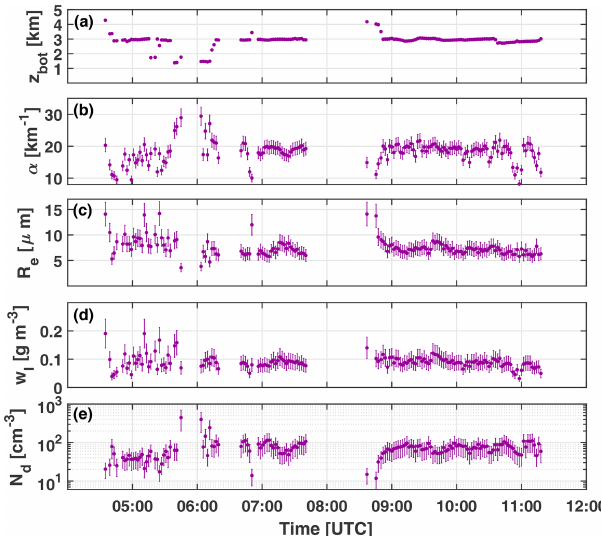
Figure 4. Dual-FOV polarization lidar observation of (a) cloud base height z bot of detected liquid cloud layers, (b) cloud extinction co- efficient α(z ref ) , (c) droplet effective radius R e (z ref ) , (d) liquid- water concentration w l (z ref ) , and (e) droplet number concentration N d (z ref ) for the liquid-water clouds mostly located between 3.0 and 3.5km height shown in Fig. 2. z ref is 75m above the cloud base. Time resolution is 120s. Error bars indicate the estimated overall uncertainty in the retrieved values.